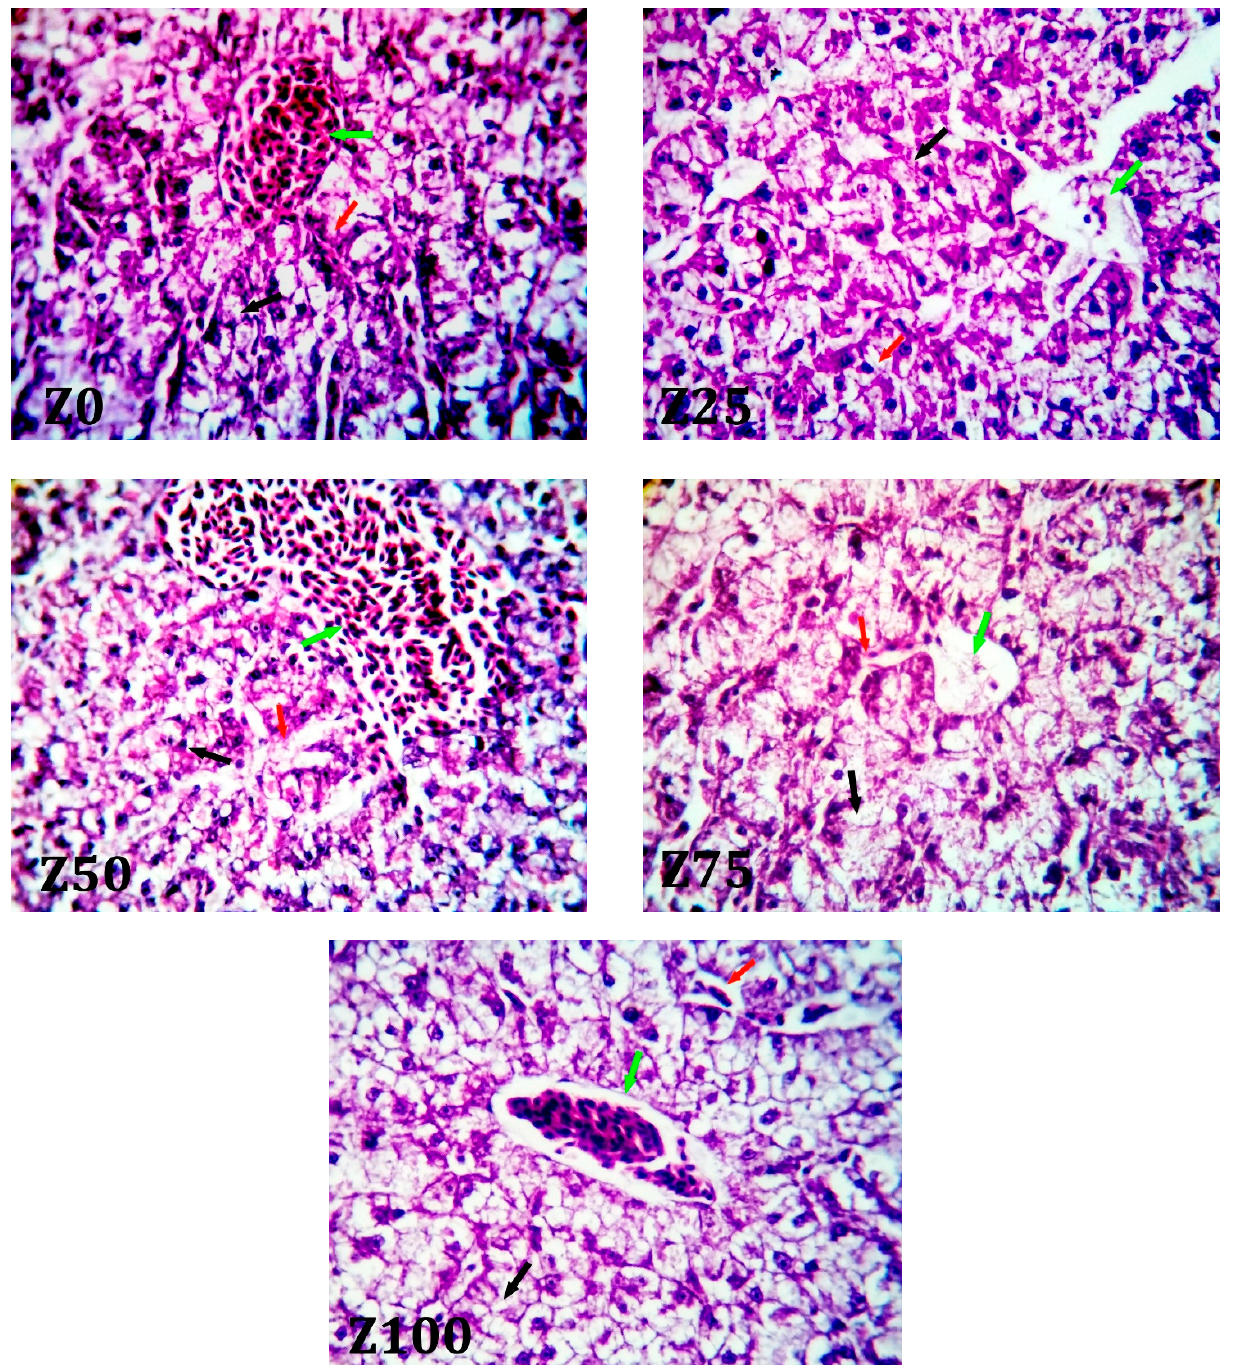
Figure 4. Photomicrograph from liver of the control group showing normally organized hepatic lobules with ill district boundaries and radially arranged hepatic cords (black arrows) around a well-formed thin-walled central veins enfgorged with nucleated erythrocytes (green arrow). Hepatic sinusoids are seen among the hepatic cords (red arrows). There was no histopathological change in the other groups except Z 75 and Z100; hepatic blood vessels and hepatic sinusoids in this group appeared moderately dilated, with increased numbers of circulating erythrocytes (green arrows). Z 0 = diet without zooplankton biomass meal (ZBM) inclusion; Z 25 , Z 50 , Z 75 , and Z 100 have 25, 50, 75, and 100% fishmeal replaced with ZBM, respectively.